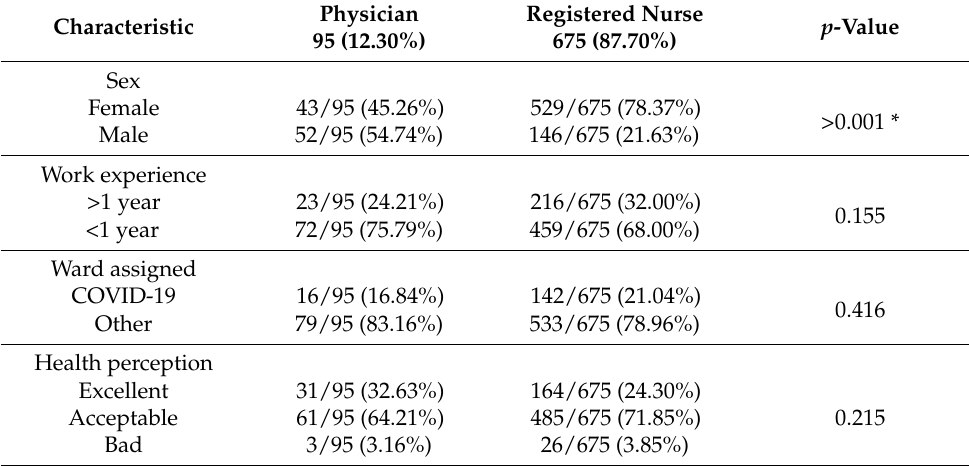
Table 1. Sampling characteristics ( n =